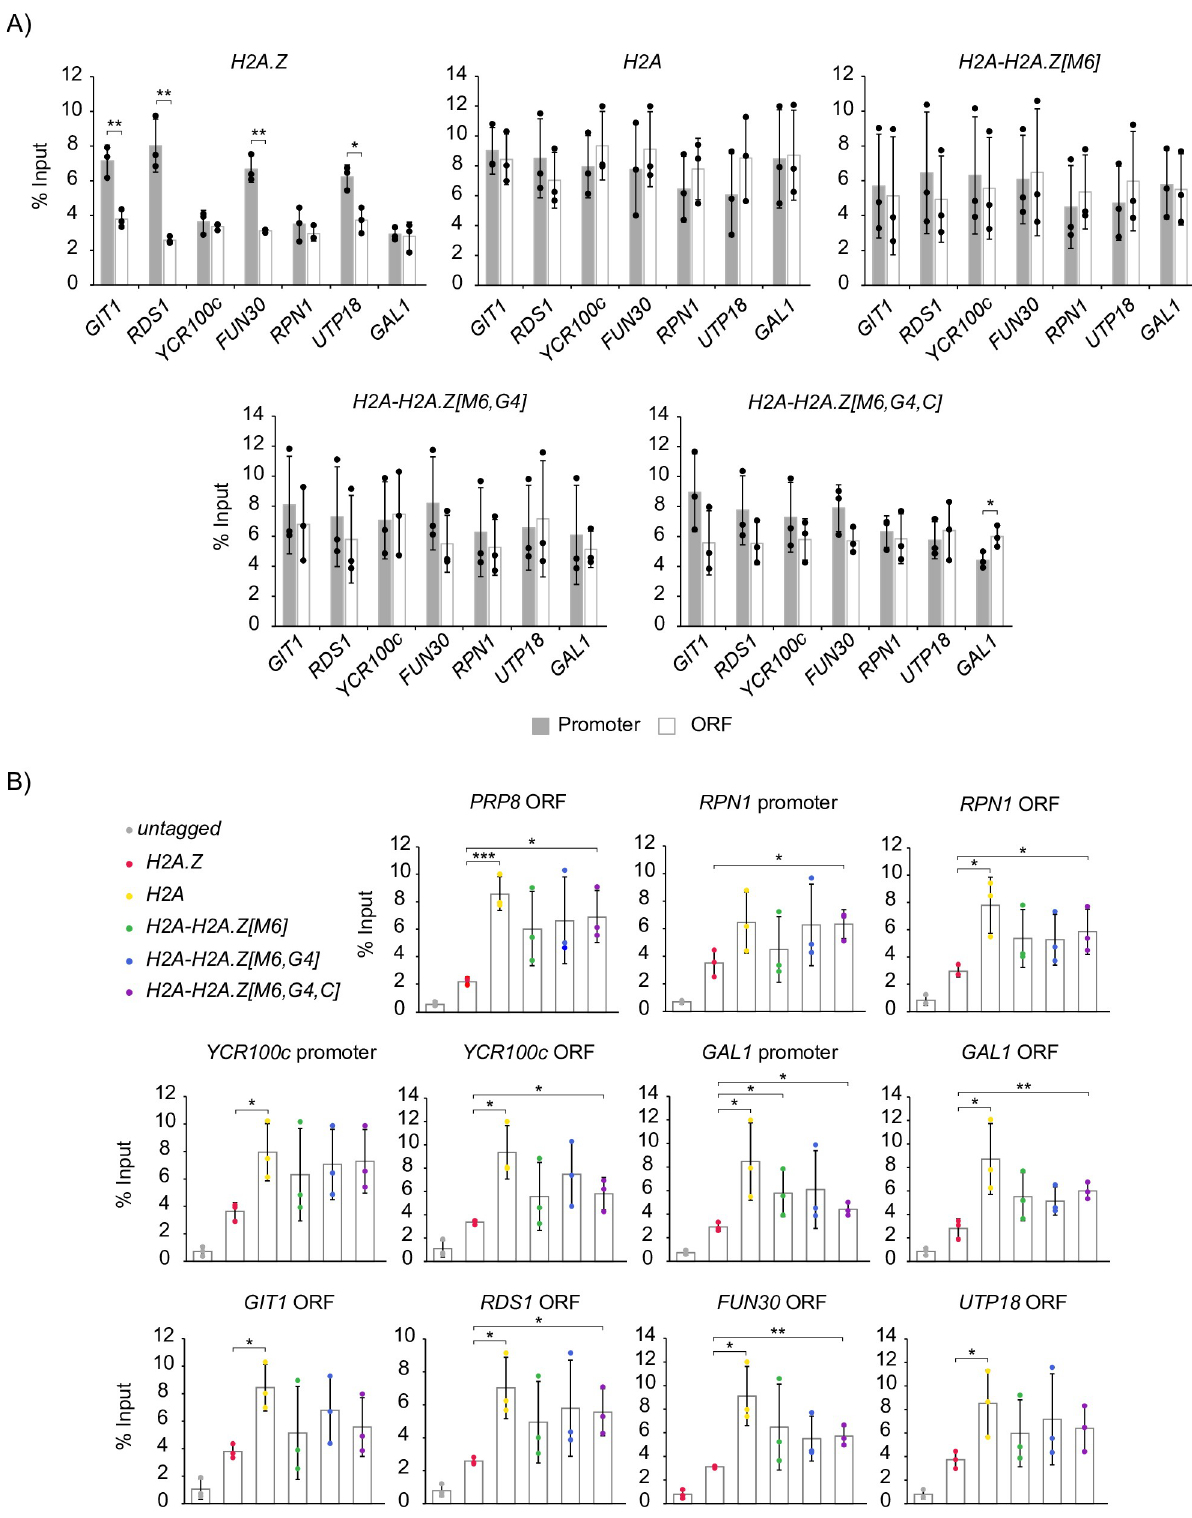
Fig 6. H2A-H2A.Z hybrid constructs were incorporated into chromatin but did not recapitulate H2A.Z-specific patterns of enrichment at gene promoters. (A) Unlike H2A.Z, the H2A-H2A.Z[M6], H2A-H2A.Z[M6,G4], and H2A-H2A.Z[M6,G4,C] constructs were not significantly enriched at promoters in comparison to their enrichment at respective gene ORFs. (B) At loci with relatively lower levels of H2A.Z, the H2A and H2A-H2A.Z